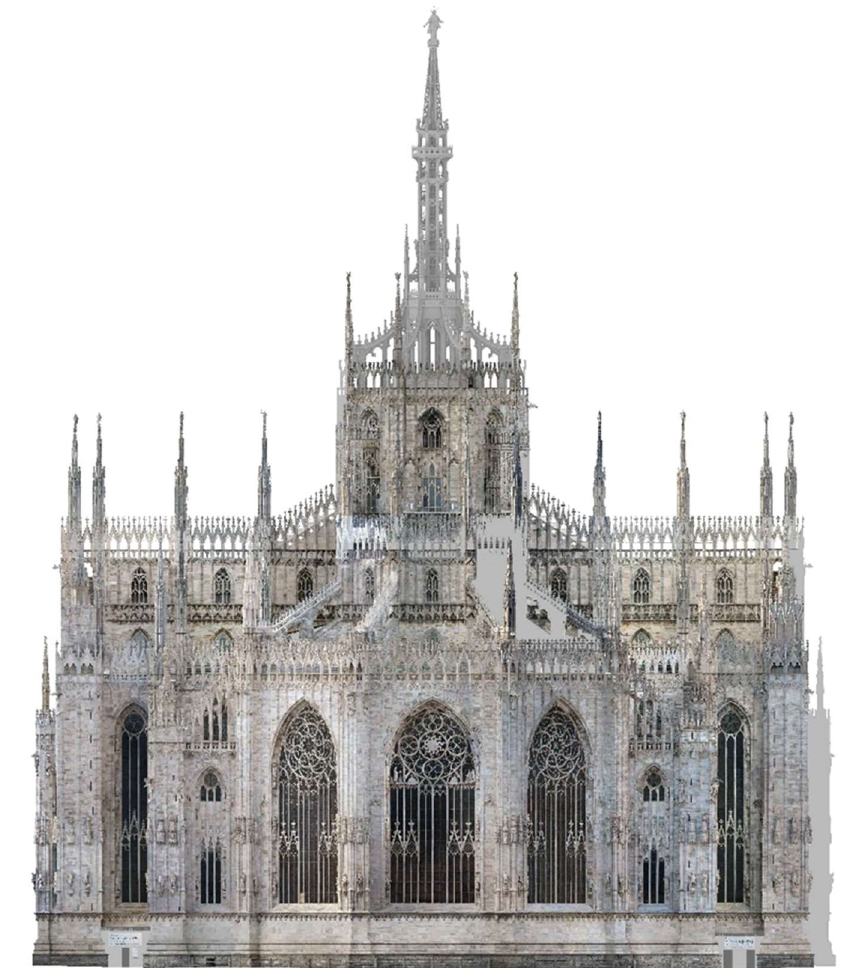
Figure 8. Orthophoto of the East façade: 3580 images, around 1.2 billion pixels (GSD